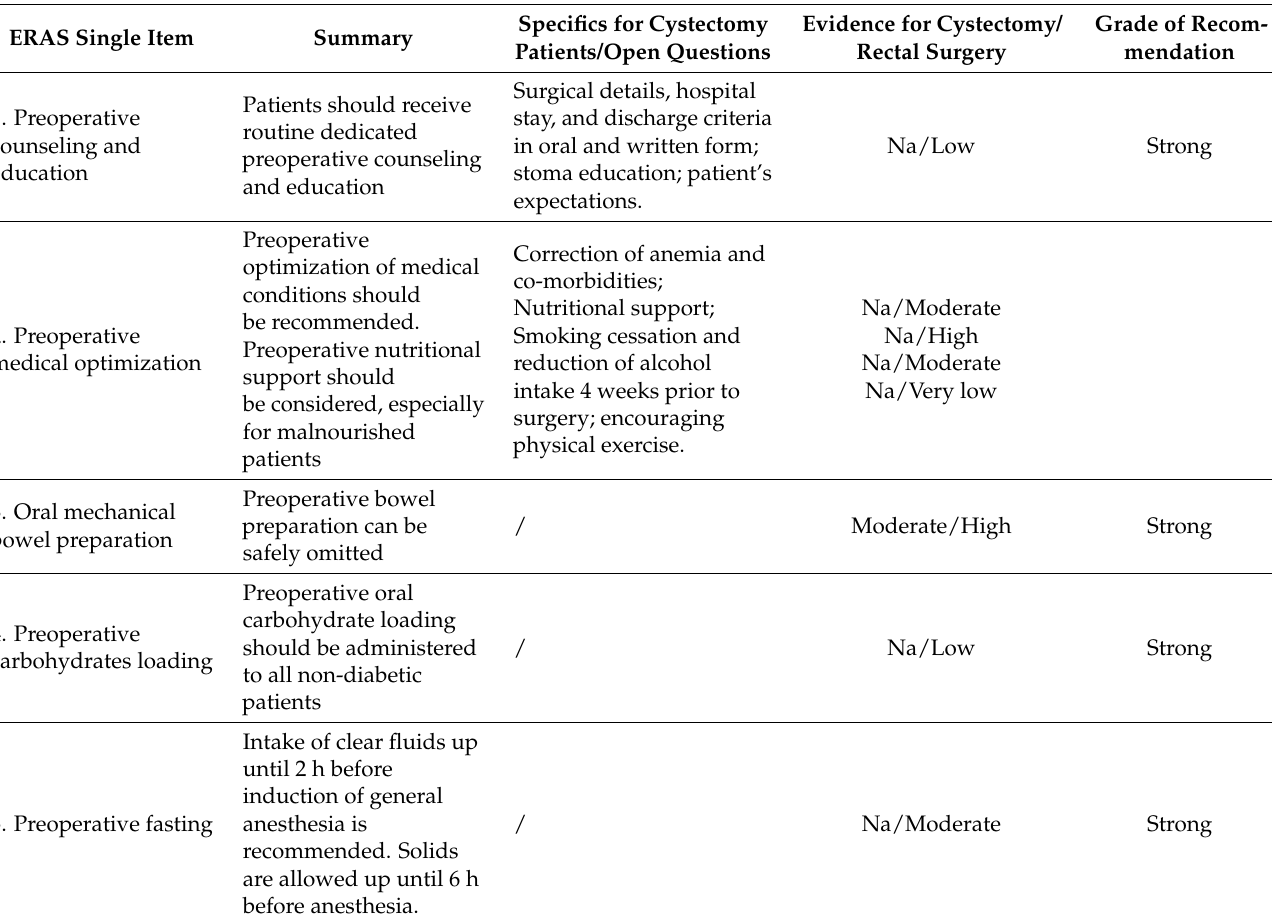
Table 1. A summary of each ERAS item and their respective level of evidence and grade of recom- mendation derived from both the cystectomy and the colorectal